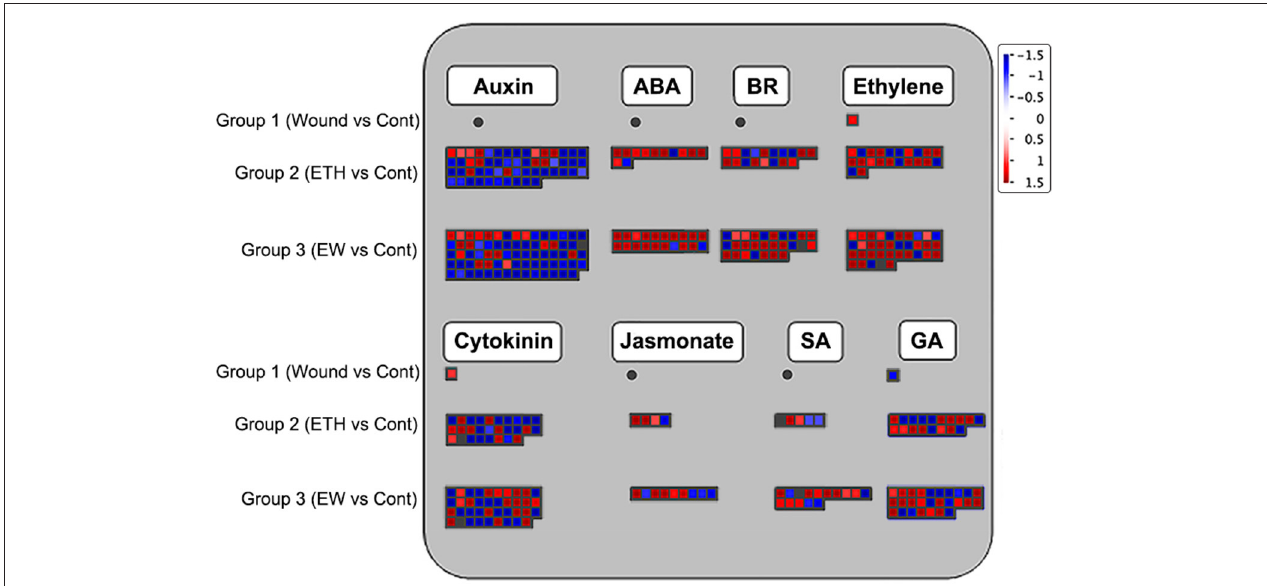
FIGURE 2 | Display of differentially expressed genes (DEGs) involved in hormone biosynthesis and signaling transduction pathway. Significant DEGs (fold changes ≥ 2 and adjusted p -value ≤ 0.05) were organized into functional categories (BINs) (Thimm et al., 2004) and visualized using the MapMan software (version 1.0). The color set scale was placed on the top right, and the gene expression increased is indicated in red and decreased in blue. Detailed information on gene expression is listed in Supplementary Table 2 .